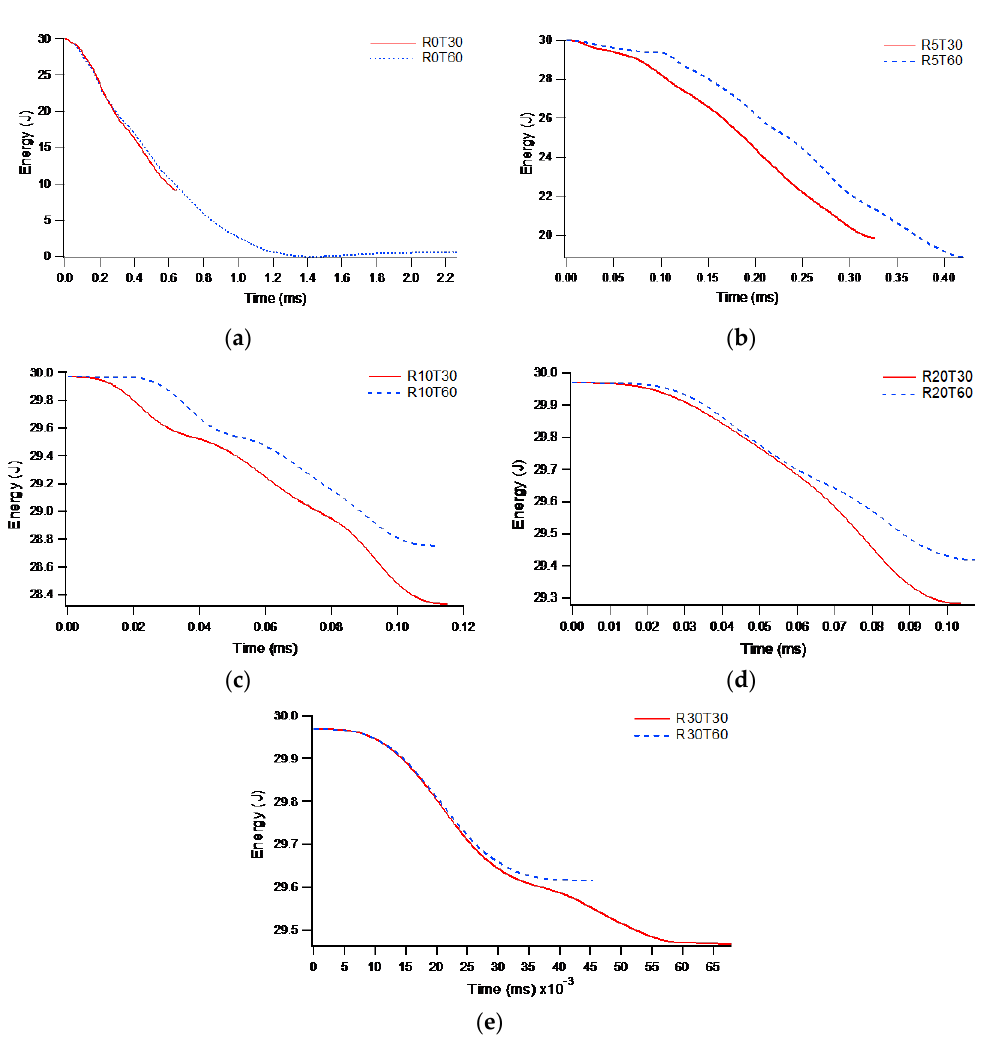
Figure 14. Variation of energy versus time (E−t) curves of impactor for: ( a ) un-reinforced iron specimen sintered for 30 min and 60 min (R0T30, R0T60); ( b ) Fe + 5 vol.% B 4 C sintered for 30 min and 60 min (R5T30, R5T60); ( c ) Fe + 10 vol.% B 4 C sintered for 30 min and 60 min (R10T30, R10T60); ( d ) Fe + 20 vol.% B 4 C sintered for 30 min and 60 min (R20T30, R20T60); ( e ) Fe + 30 vol.% B 4 C sintered for 30 min and 60 min (R30T30, R30T60).